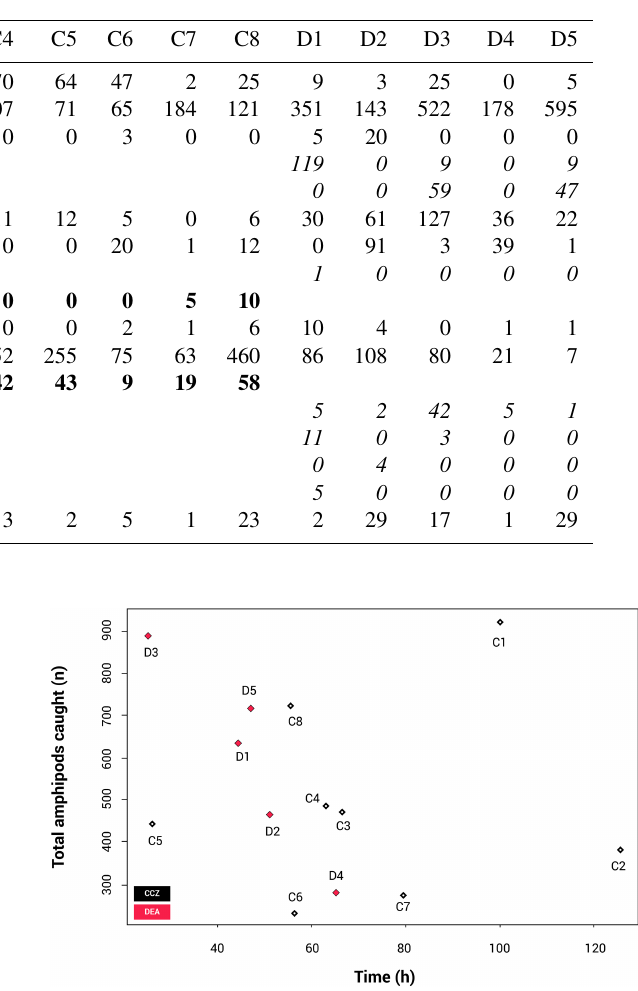
Table 2. Distribution and abundances of morphotypes across the Clarion–Clipperton fracture zone (CCZ) and DisCOL experimental area (DEA). For the numerical values the following format has been used: normal font is shared, italic font is DEA only and bold font is CCZ only.